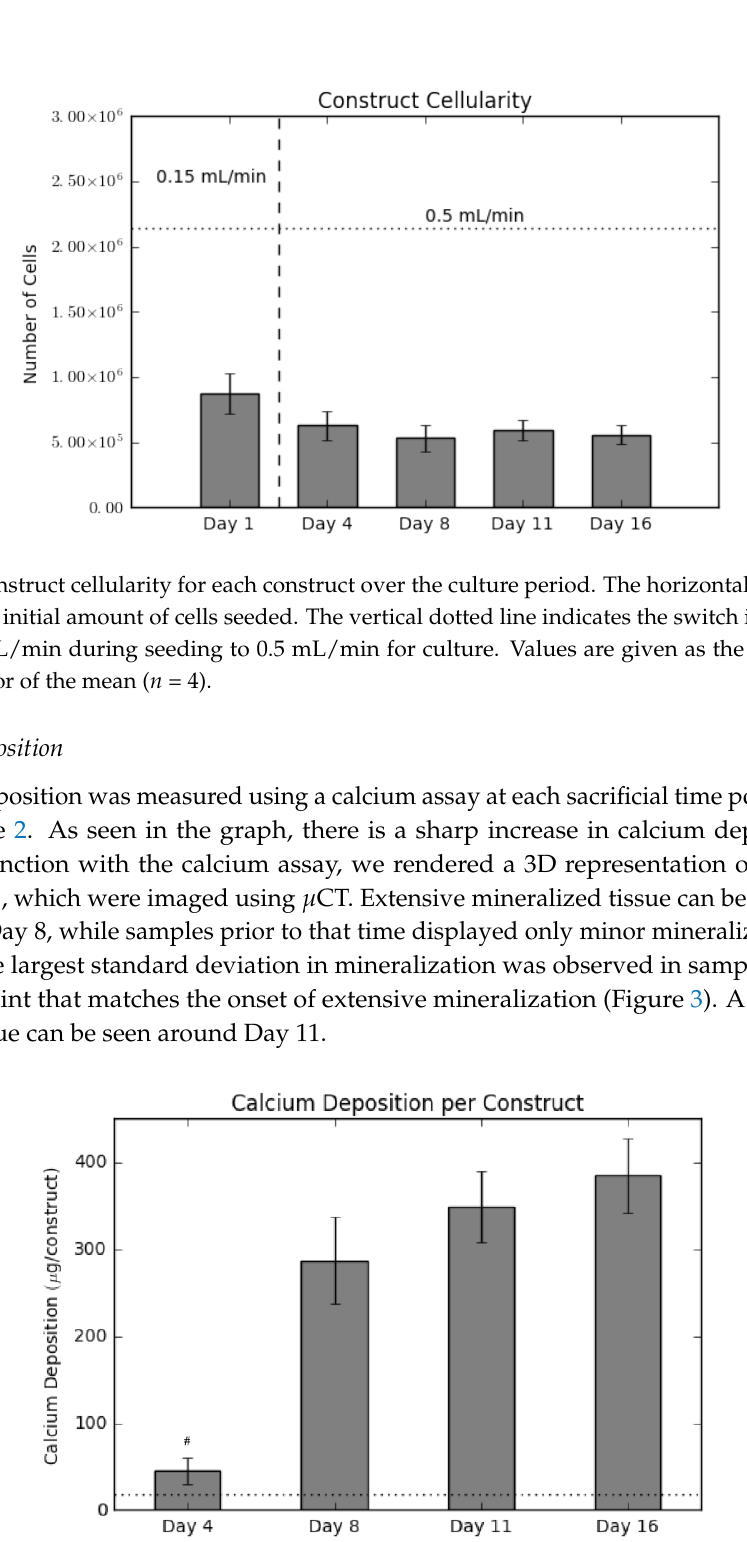
Figure 2. Calcium levels present within each construct over the culture period. The horizontal dotted line represents the background signal for an empty construct. Values are given as the mean ± the standard error of the mean ( n = 4). The # signifies the significantly lowest value ( p <